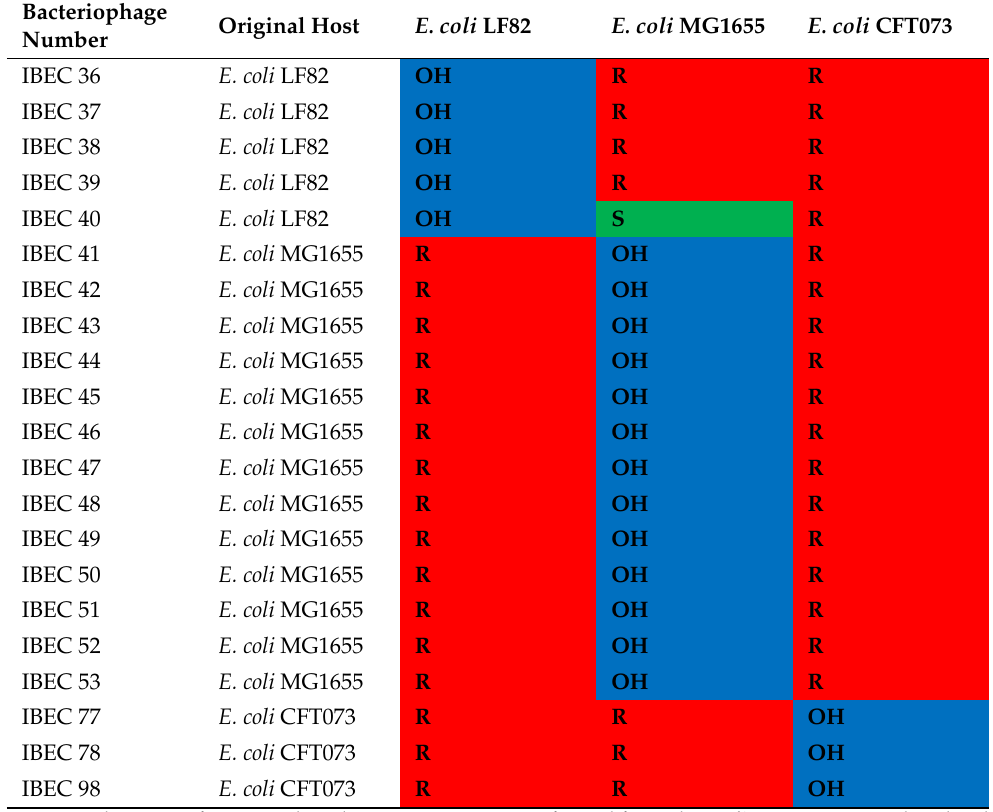
Table 2. Cross-infective phages against different E. coli clinically isolated strains. Original host strains (clear zone of lysis, OH: blue), susceptible bacterial strains (clear zone of lysis, S: green), and resistant strains (no zone of lysis, R: red) against phage